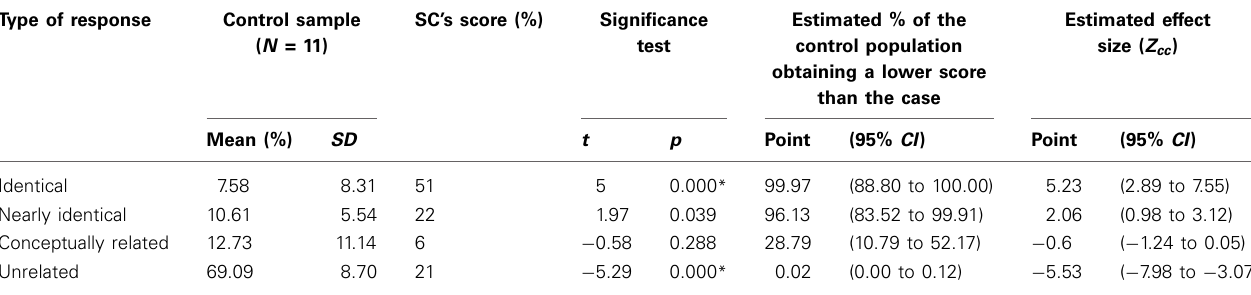
Table 2 | Differences in consistency scores for word-taste associations between SC and controls.